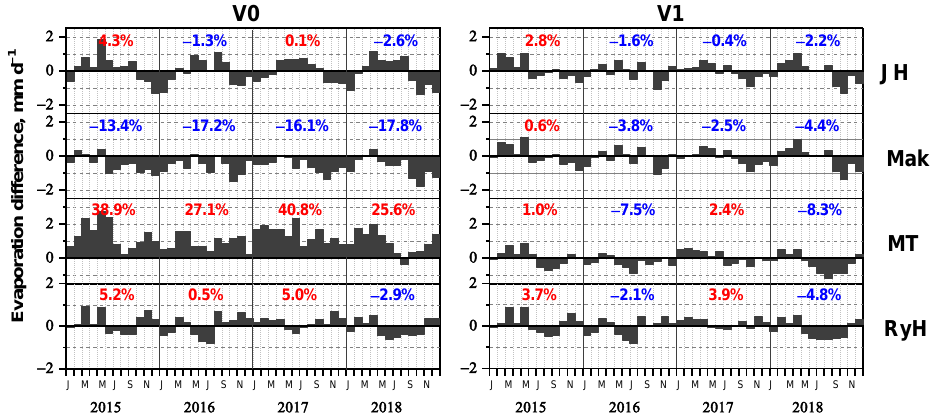
Figure5. ThesameasFigure4, butforthesolarradiation-basedmethods(JHandMak)andDalton-based Figure 5. The same as Figure 4, but for the solar radiation-based methods (JH and Mak) and Dalton- methods (MT and based methods (MT and RyH).